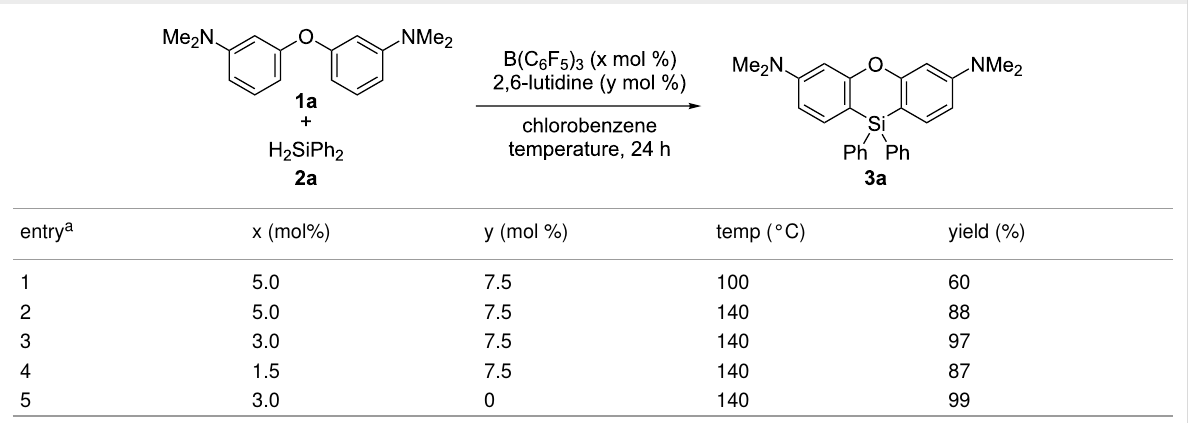
Table 1: Optimization of the reaction conditions for the synthesis of phenoxalin 3a